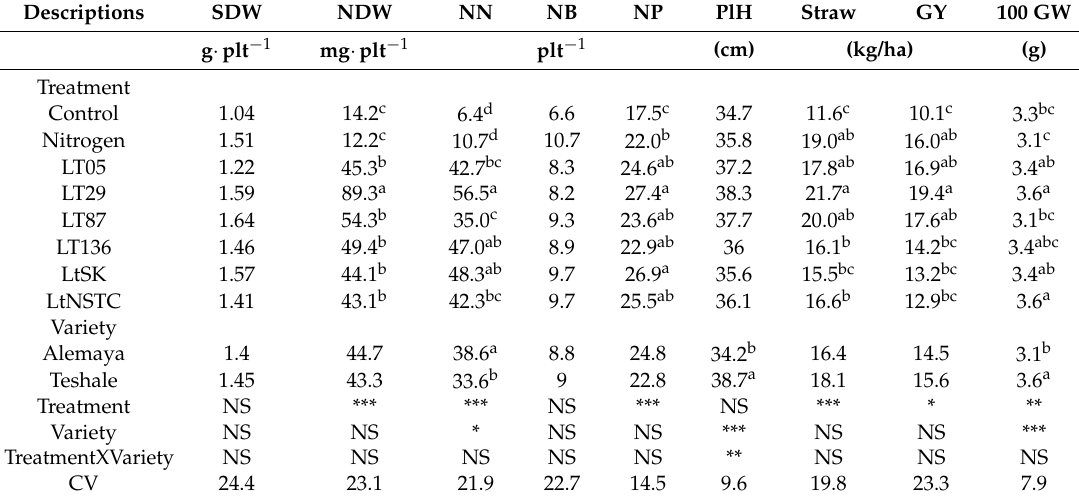
Table 4. Effect of Rhizobium inoculation and N fertilizer application on nodule number (NN), nodule dry weight (NDW), shoot dry weight (SDW), grain yield, and yield component in Huletegna Choroko soil under greenhouse